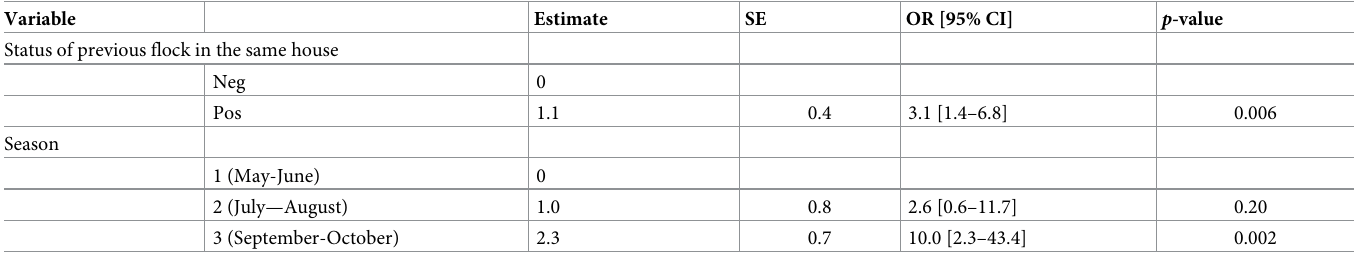
Table 2. Risk factors for occurrence of ESC-resistant Enterobacteriaceae in Norwegian broilers. Results from the multivariable generalized model including a random effect of HouseID built to identify possible risk factors for occurrence of extended-spectrum cephalosporin-resistant Enterobacteriaceae in Norwegian broiler flocks (n = 1307) sampled from May-October